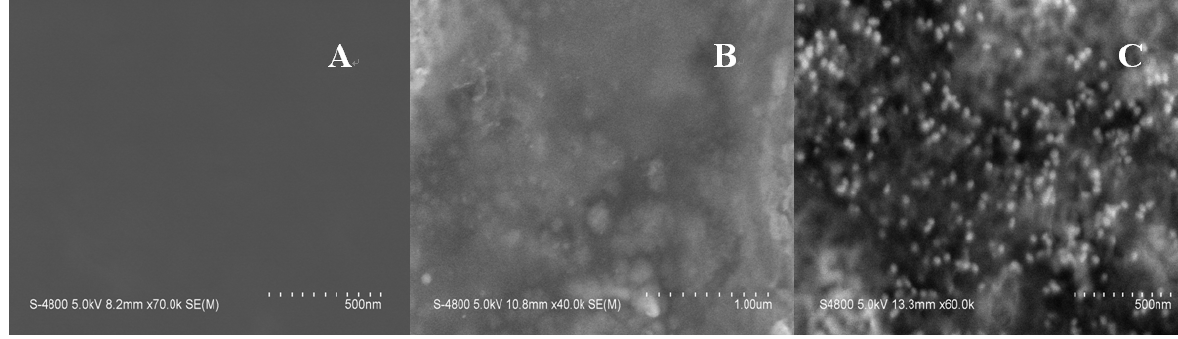
Figure 1. SEM images of ( A ) the bare Au electrode surface; ( B ) the Au electrode surface after hybridizing capturing probe with linking probe 1 in 0.5 µM Hg 2+ solution